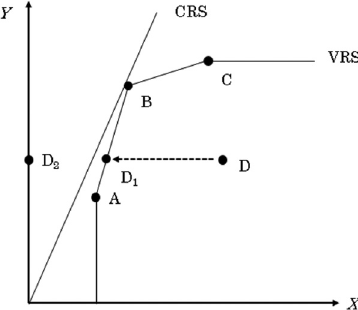
Figure 1. An example of